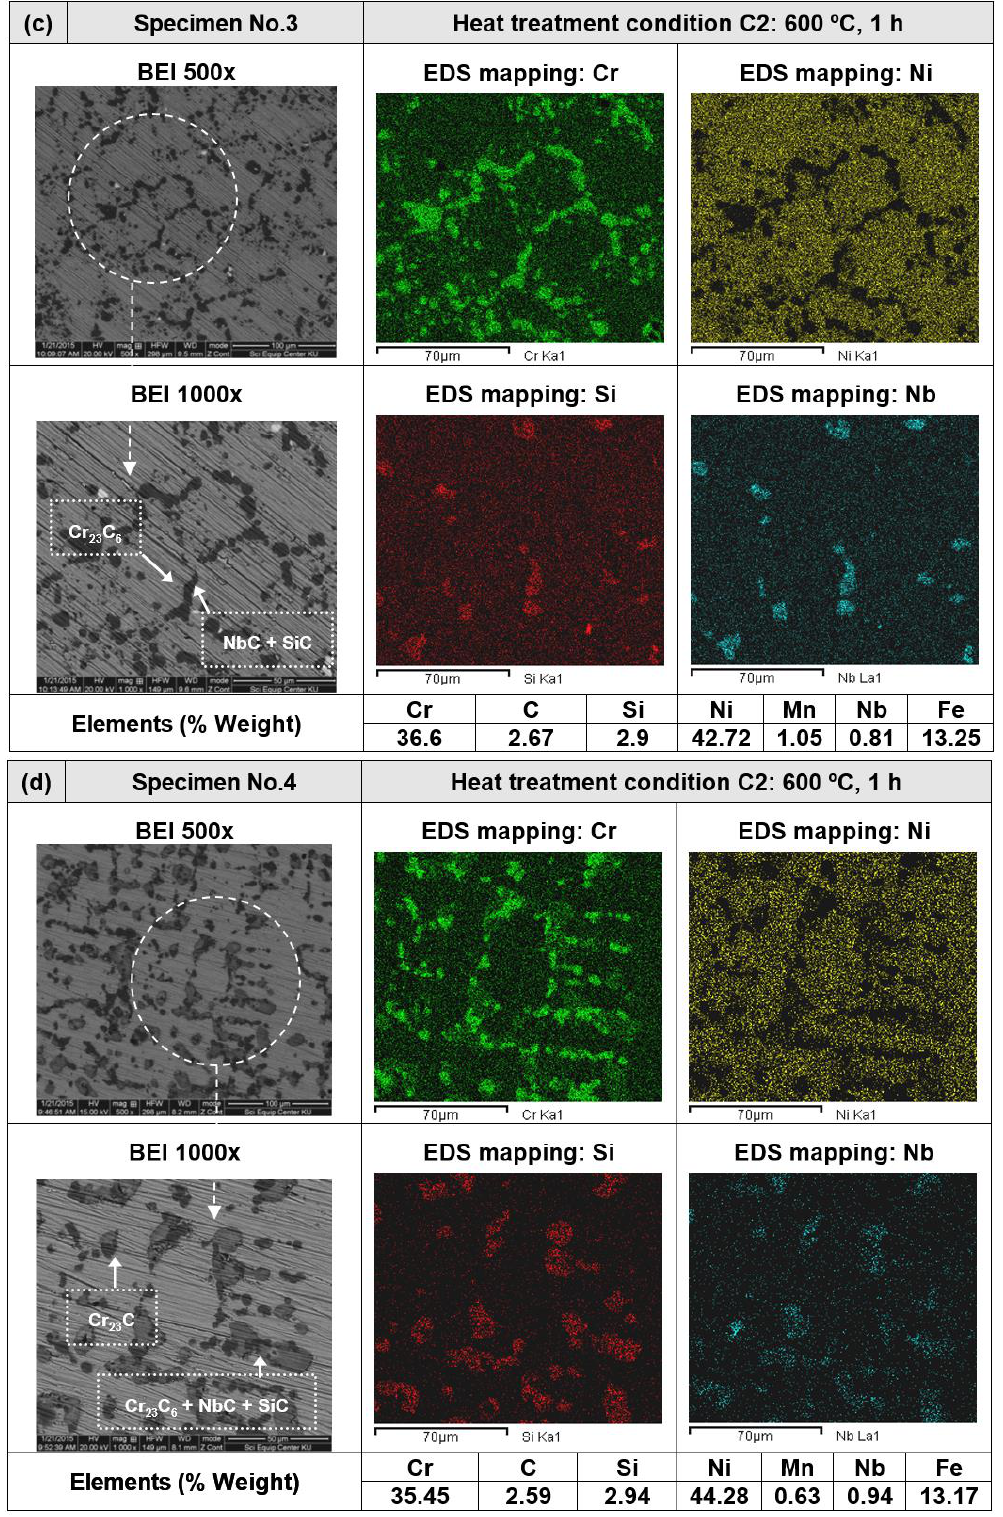
Figure 6. BEI and EDS mapping of the 35Cr-45Ni-Nb specimens after 1 h of thermal heat treatment at 600 ˝ C: ( a ) Specimen No. 1; ( b ) Specimen No. 2; ( c ) Specimen No. 3; ( d ) Specimen No.